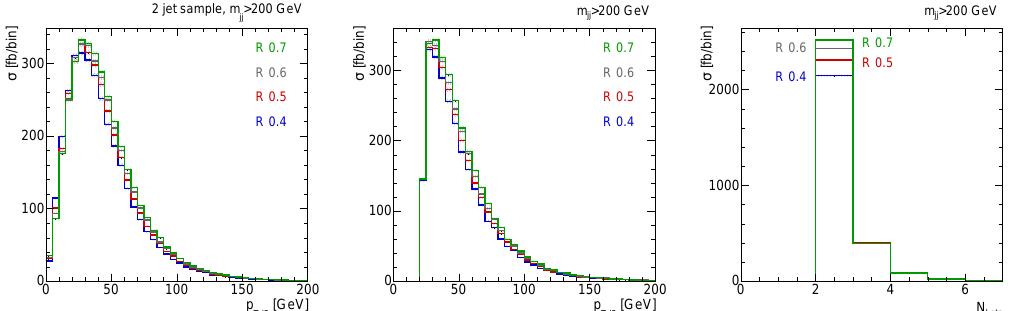
Figure 3: WBF signal distributions for the exclusive two-jet sample (left) and the full sample (center and right) requiring only m